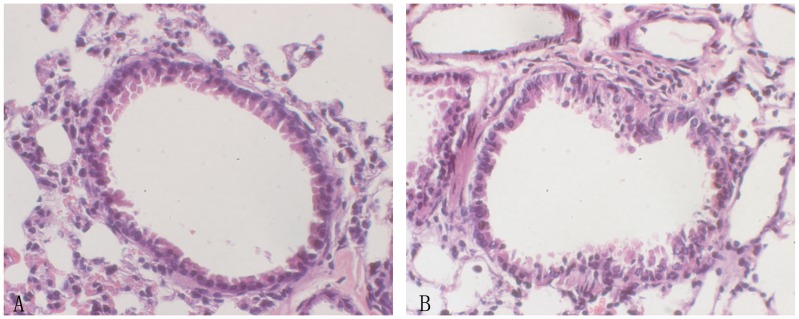
HE staining of lung tissue in OVA-sensitized asthmatic group and control group.
A, control group; B, asthmatic group (Original magnification×400). Asthmatic group showed bronchial inflammation that exsisted in the forms of epithelial damage, wall thickening of the tunica mucosa bronchiorum, inflammatory cell infiltration into the lower layer of the mucous membrane and the surrounding bronchus, and accrementition and spasm of airway smooth muscle.